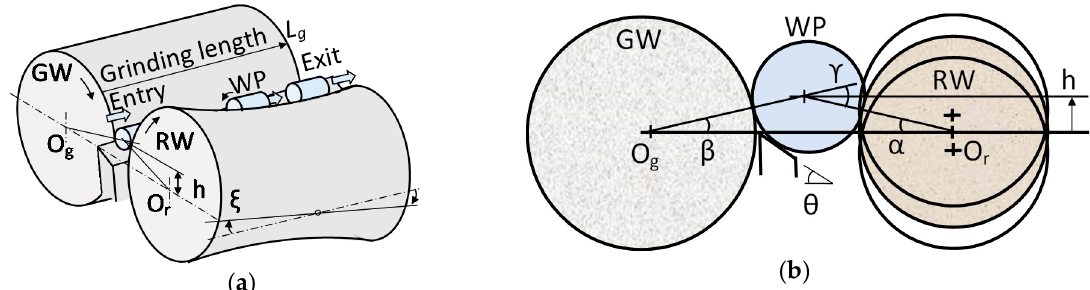
Figure 1. Through ‐ feed centerless grinding. ( a ) Geometrical arrangement; ( b ) Section view at the center.